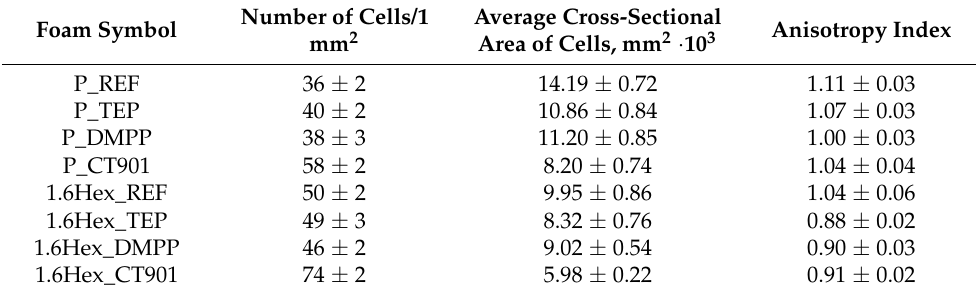
Table 3. Parameters of foams cell structure in the direction perpendicular to the foam